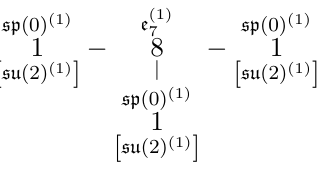
Table 5. Higgsings associated to SU(4) 2 × SU(2) of (2.66). N f = 1 in the fundamental